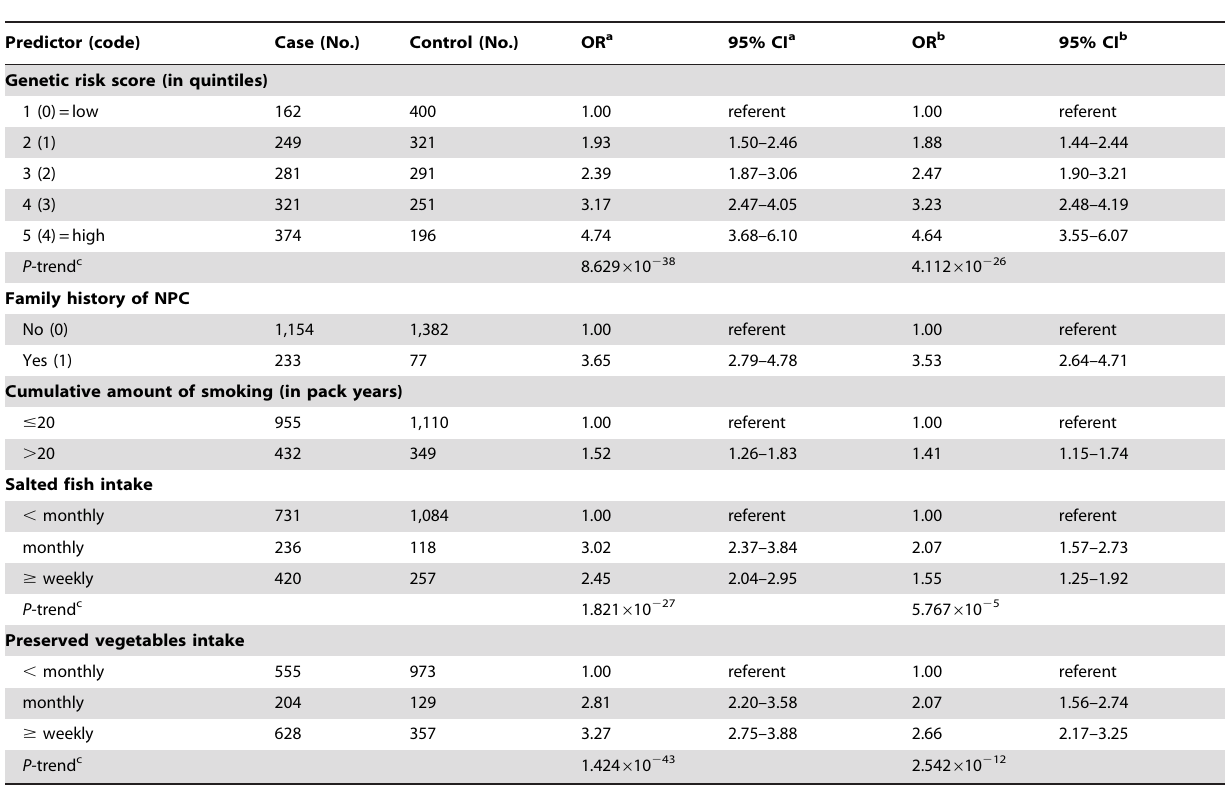
Table 2. Associations between genetic variants, epidemiological risk factors and risk of nasopharyngeal carcinoma.